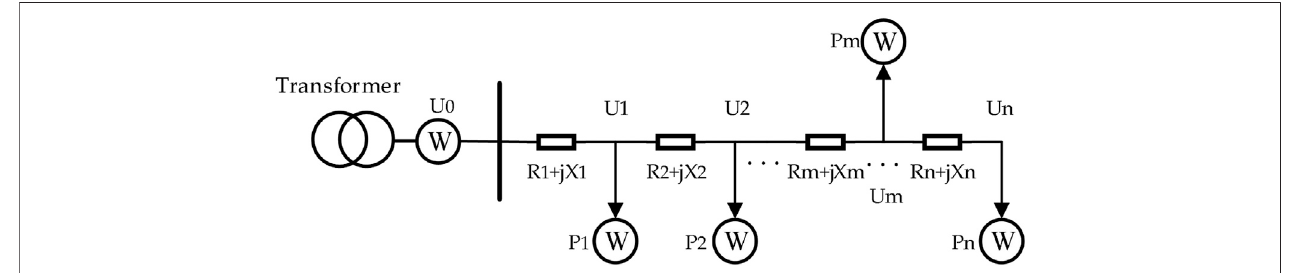
FIGURE 1 | Schematic diagram of single-phase power fl